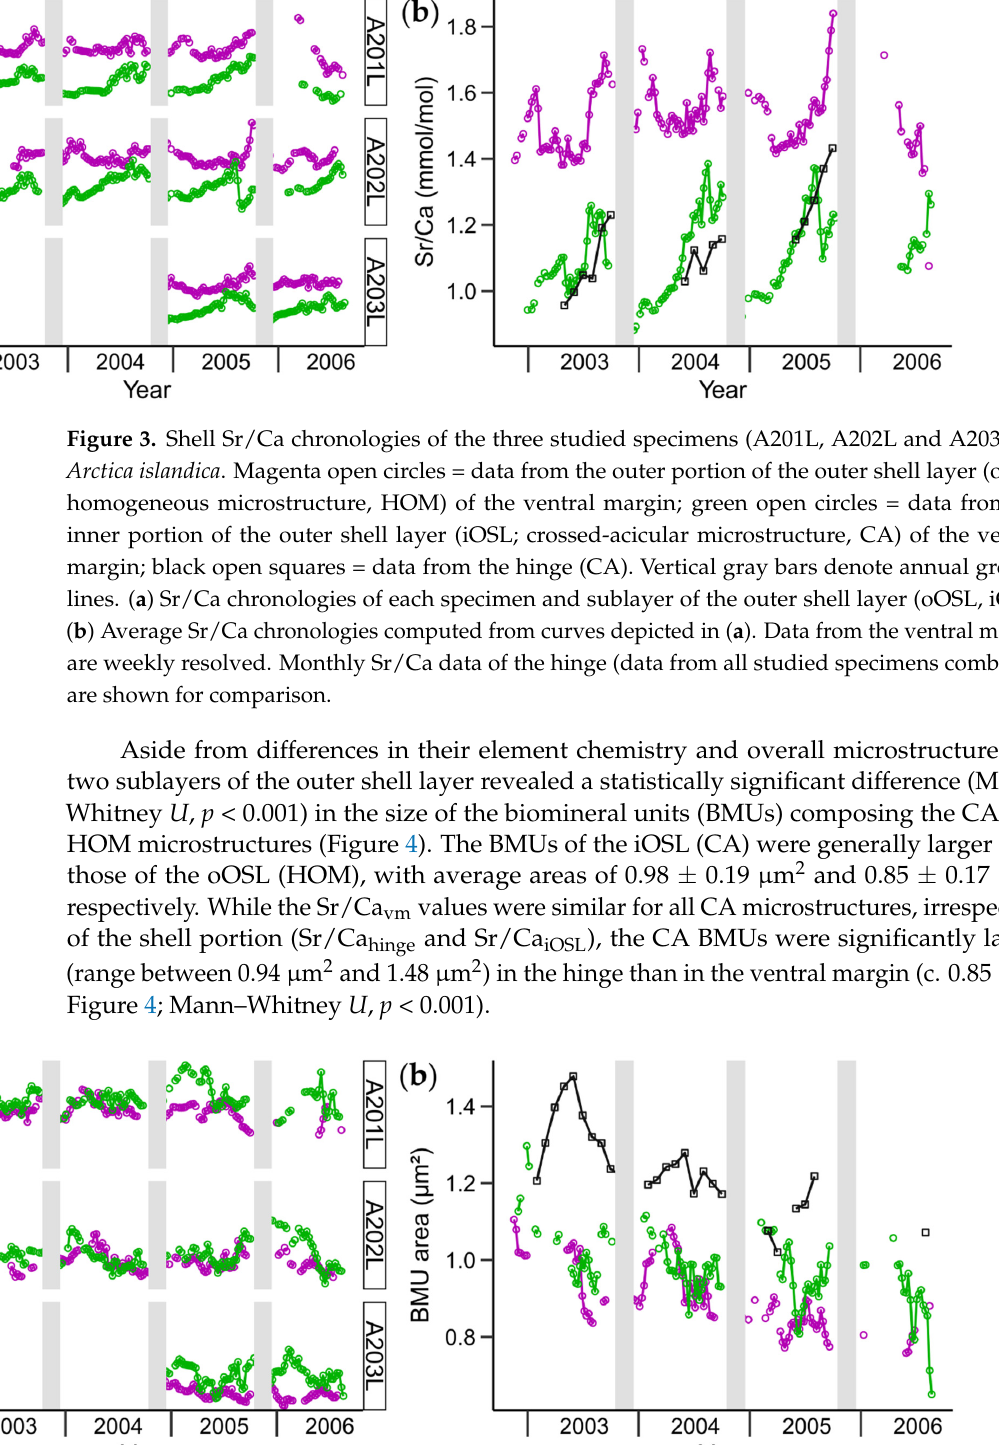
Figure 4. Average biomineral unit (BMU) area chronologies of the three studied shells (A201L, A202L and A203L) of Arctica islandica . Acronyms and color coding as in caption of Figure 3. Note, magenta = homogenous microstructure (oOSL); green = crossed-acicular microstructure (iOSL). Vertical gray bars denote annual growth lines. ( a ) BMU area chronologies of each specimen and sublayer of the outer shell layer (oOSL, iOSL). ( b ) Average BMU area chronologies computed from the curves depicted in ( a ). Data from the ventral margin are weekly resolved. Monthly Sr/Ca data of the hinge (data from all studied specimens combined) are shown for